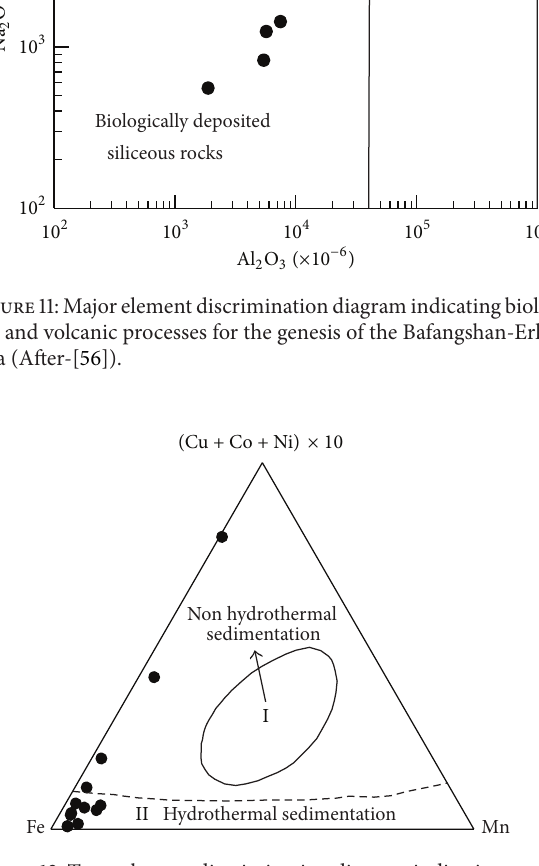
Figure 12: Trace element discrimination diagram indicating mostly hydrothermal genesis for siliceous rocks from the Bafangshan- Erlihe area